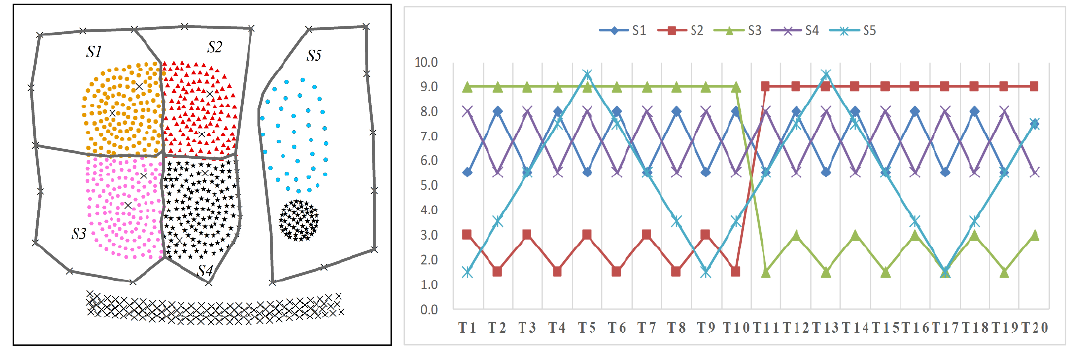
Figure 7. Time series attribute distribution of objects in S 2 and the mean value of attributes in every area.